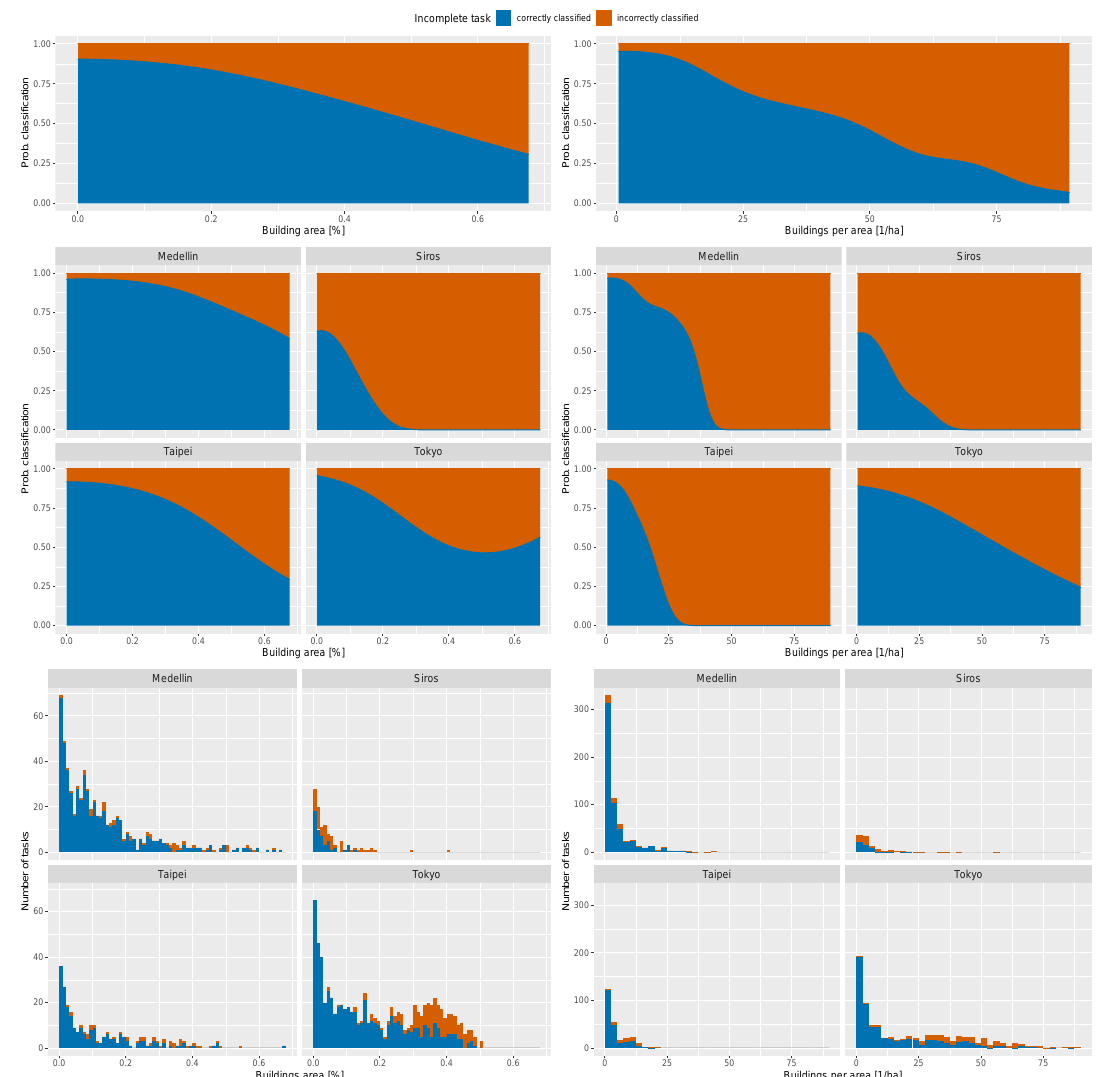
Figure 6. Conditional density plots for the classification correctness of tasks classified as “incomplete” by the volunteers dependent on the part of the task area covered by buildings (left column) or the number of buildings per hectare (right column). In addition to the plots for all sites (first row), site- specific conditional density plots are shown (second row) as well as the distribution of the explanatory variable through histograms (last row). The histograms show the two classes in a stacked